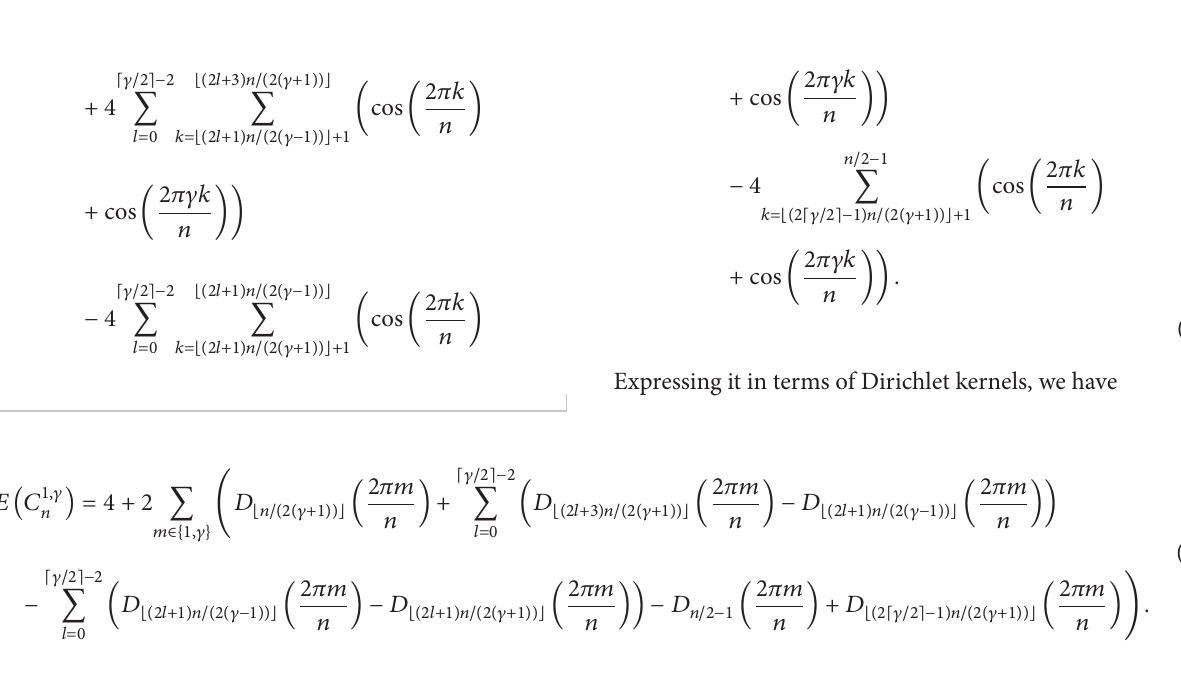
Figure 1: Energy of circulant